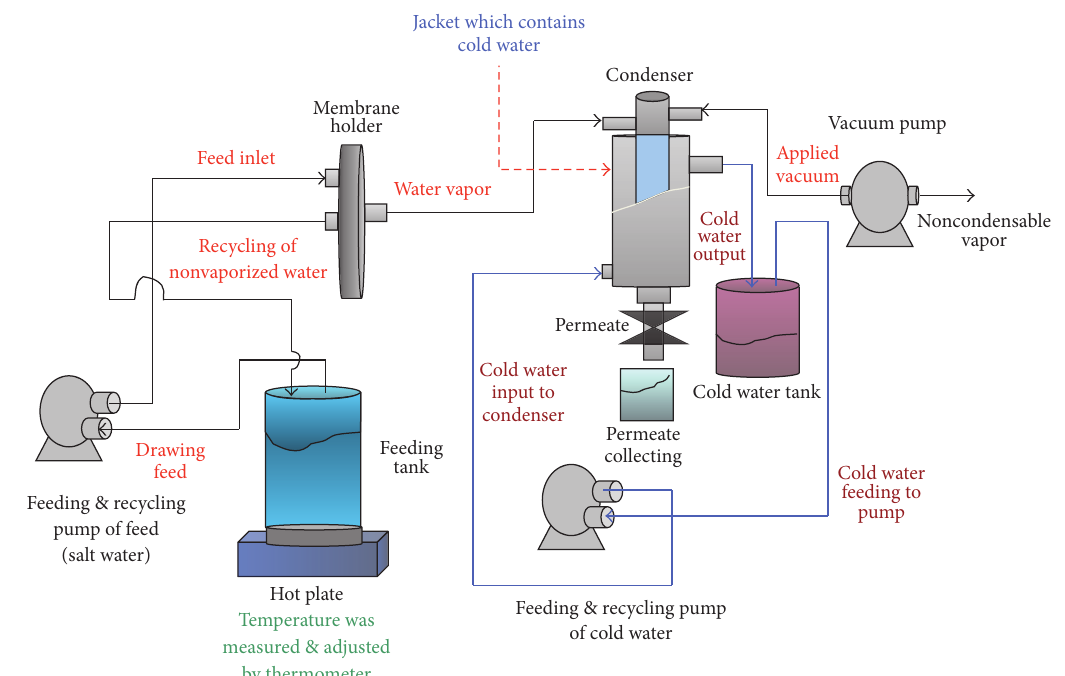
Figure 4: VMD experimental set-up.